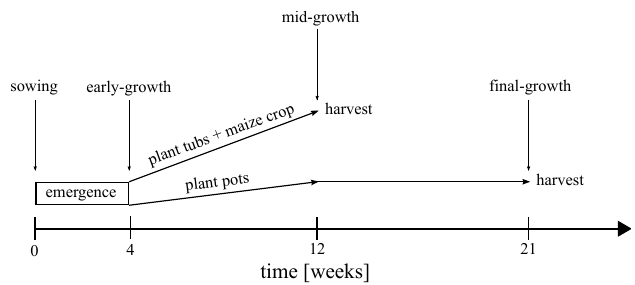
Fig. 1: Overview of the treatments performed in each replication in both climate chambers.